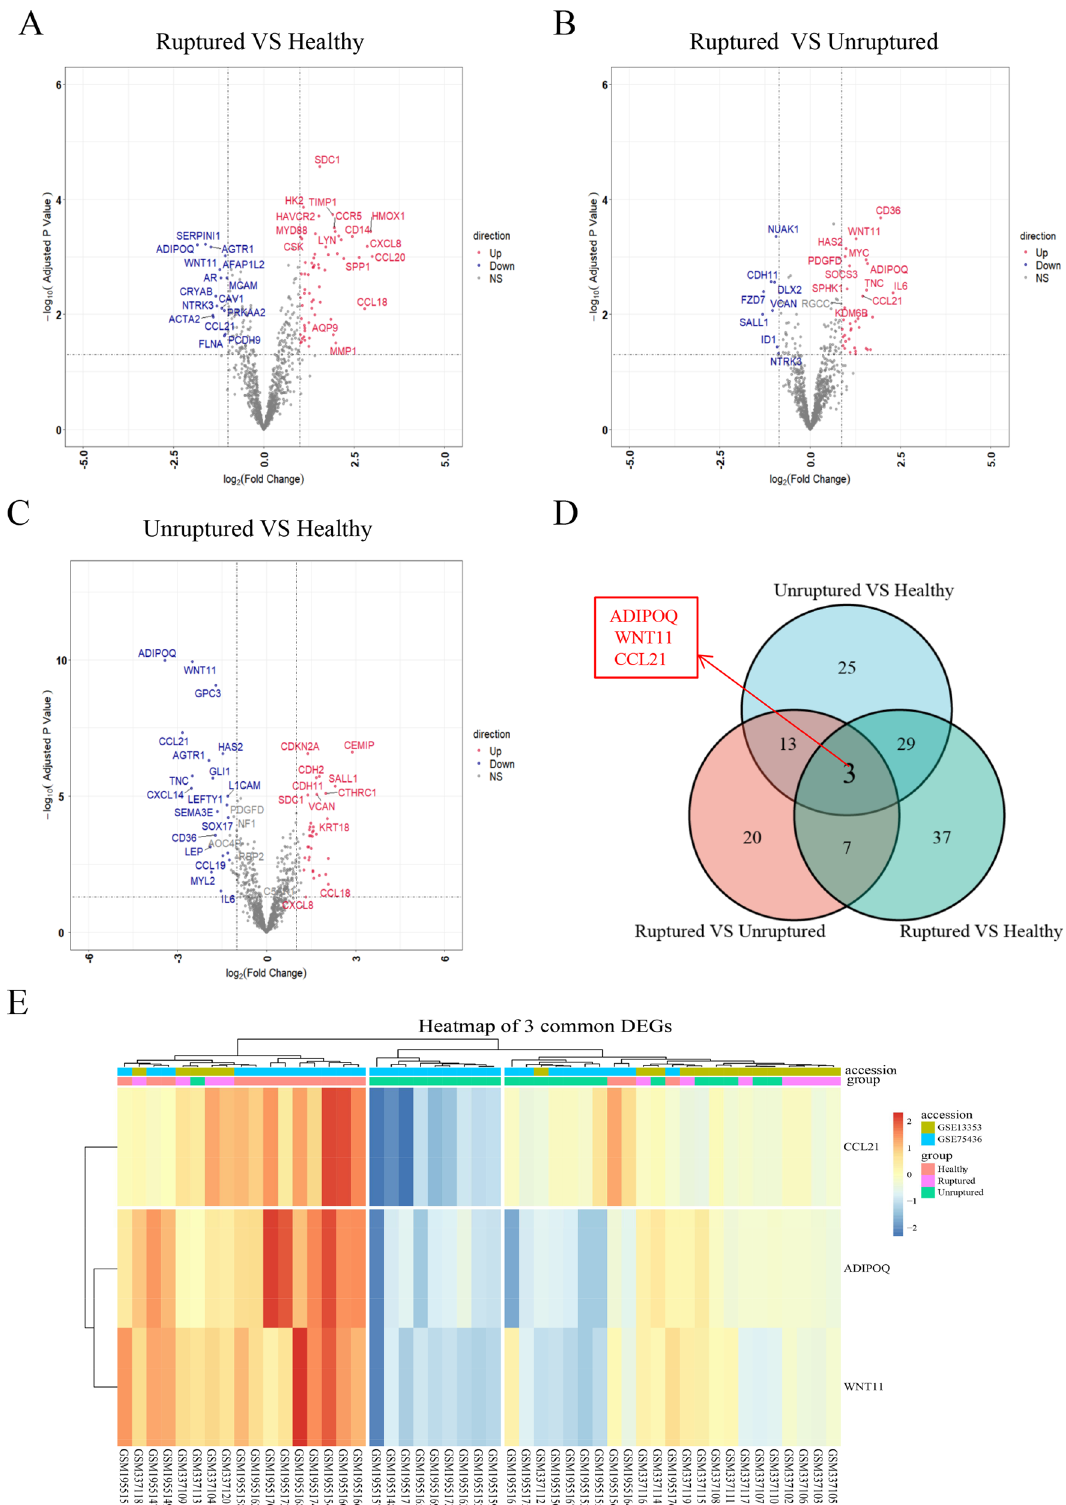
Figure 1. Sample differential gene and expression analysis. ( A ) Epithelial–mesenchymal transition (EMT)- related differentially expressed genes (DEGs) of the ruptured and healthy groups. ( B ) EMT-DEGs of the ruptured and unruptured groups. ( C ) EMT-DEGs of the unruptured and healthy groups. ( D ) Common genes among the three groups (ruptured, unruptured, healthy). ( E ) Relative expression levels of three genes ( ADIPOQ , WNT11 , and CCL21 ) in the merged dataset samples. DEGs (differentially expressed genes), up (red): upregulated genes, down (blue): downregulated genes. NS (black): no significance. Above all figures were visualized by R software